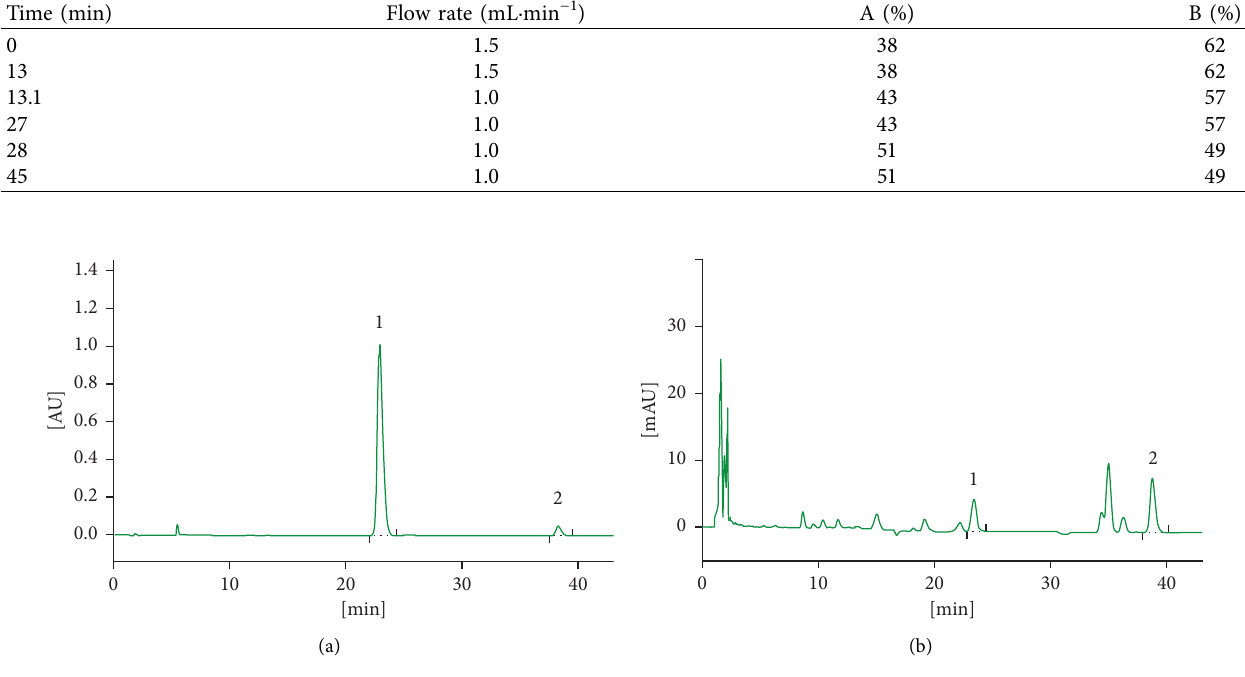
Figure 1: HPLC chromatogram of Asarum . (a) Reference substance and (b) test substance (1, methyl eugenol; 2, asarinin). Table 2: Different types of DESs.